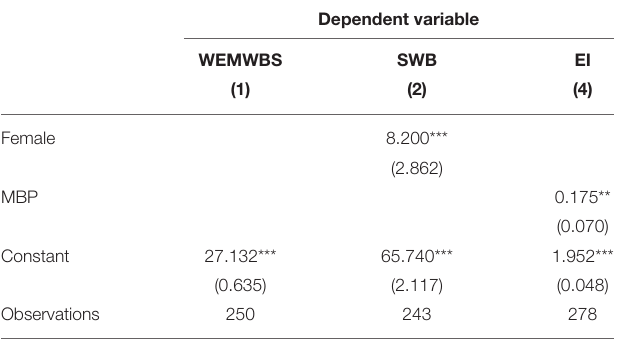
TABLE 4 | Linear regression results in India.